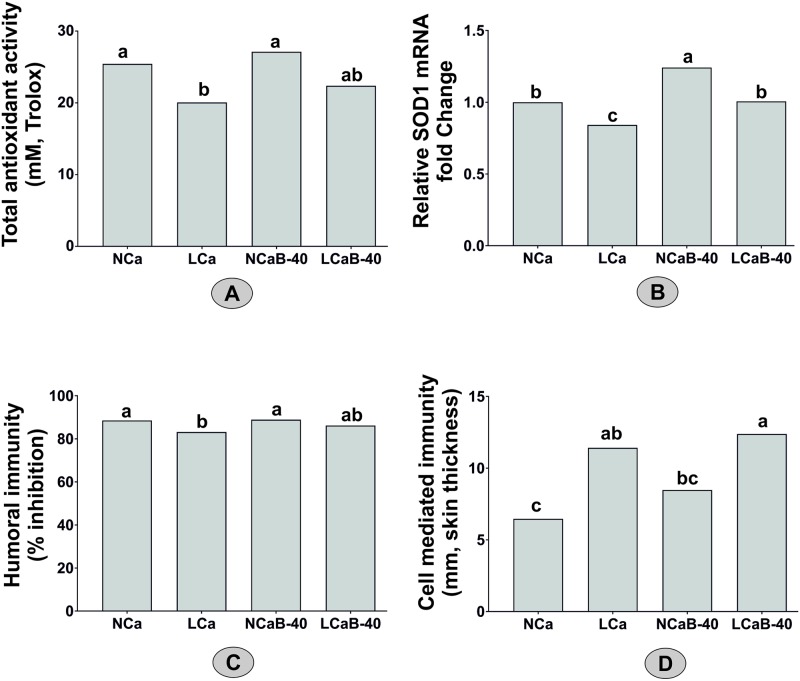
Influence of boron supplementation on total antioxidant activity, relative mRNA abundance of SOD1, humoral and cellular immune responses of lambs fed diets with or without adequate level of calcium.Note: lowered total antioxidant capacity(A), relative mRNA abundance of SOD1(B) and humoral immune responses (C) on low Ca diets are restored and cellular immune response (D) is ameliorated by Boron supplementation.